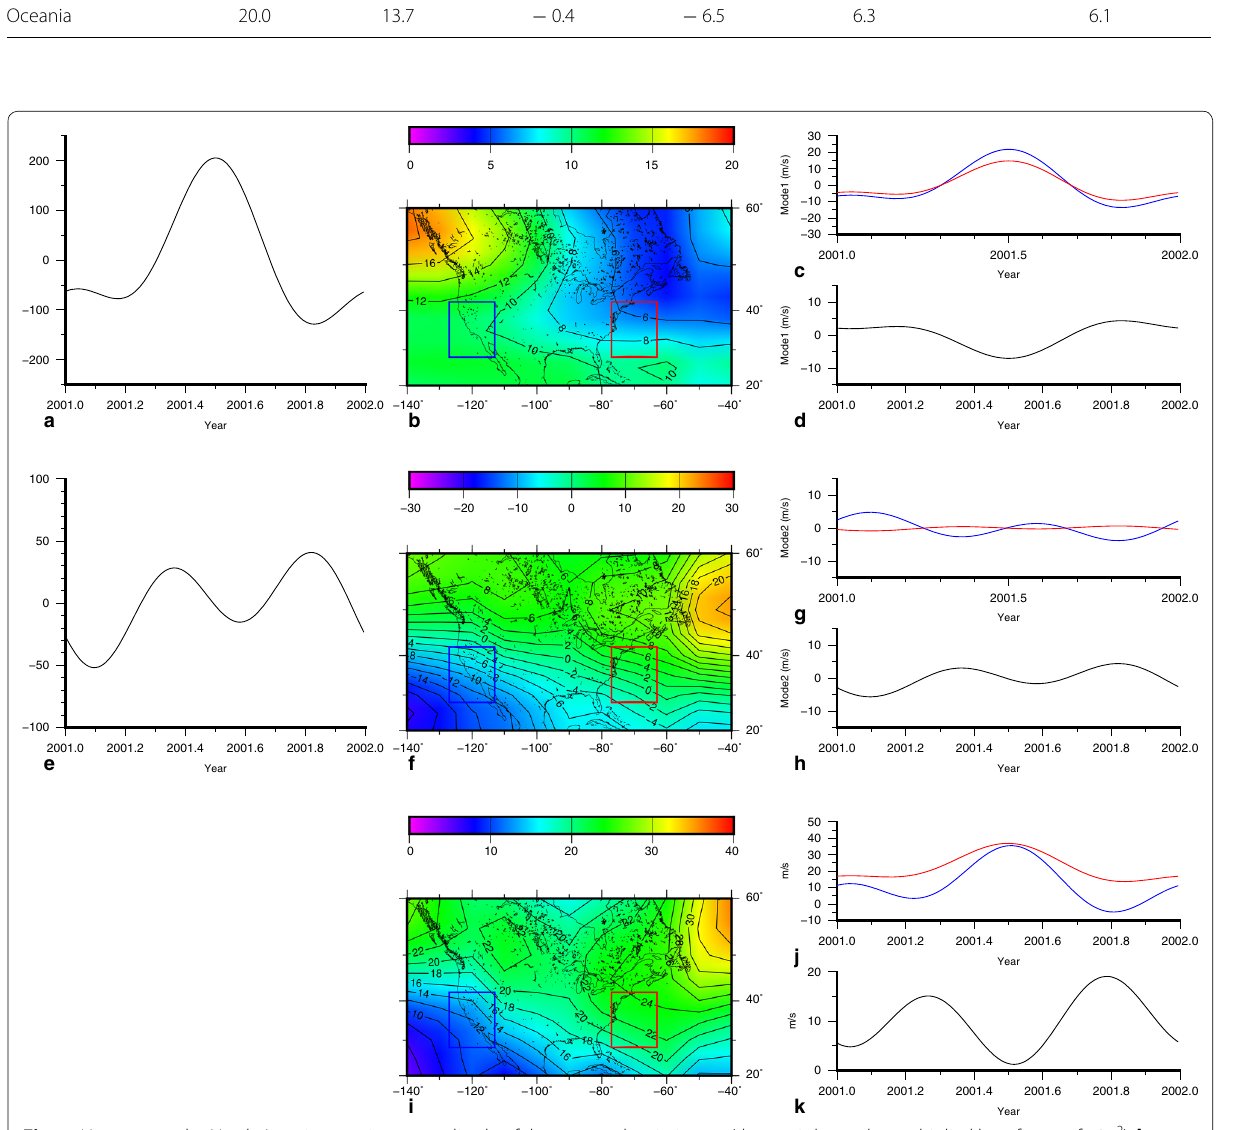
, and d V , at 00 LT for the high- GNSS HWM07